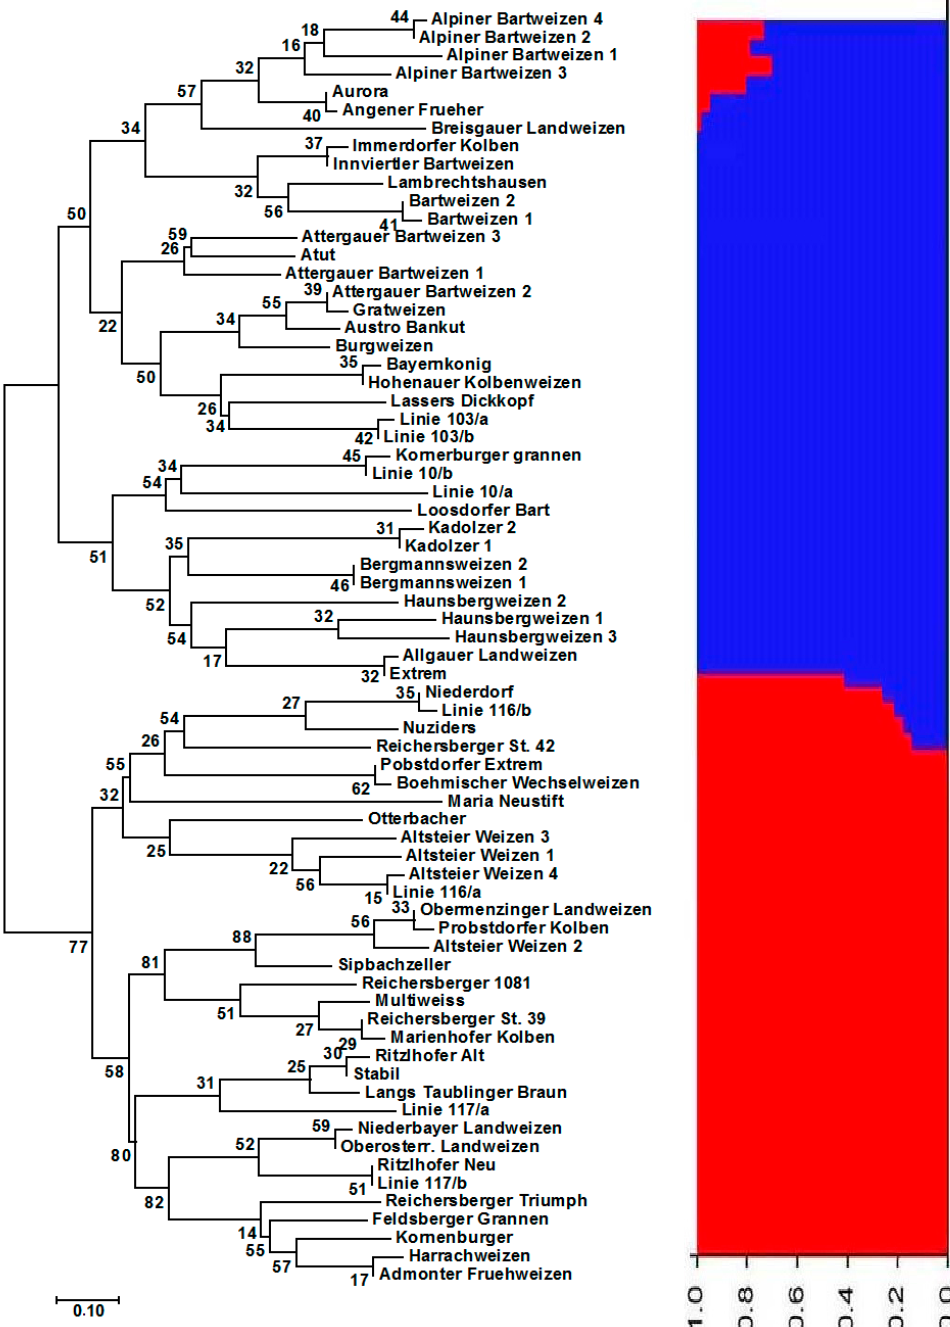
Figure 1. Neighbor-joining tree of the 70 Austrian wheat genotypes and their population structure (at K = 2) based on 1052 diversity array technology (DArT) markers. The numbers at the nodes of the phylogenetic tree represent the bootstrap values showing the probability of branching at 1000 replications. The red and blue colors represent two different populations.